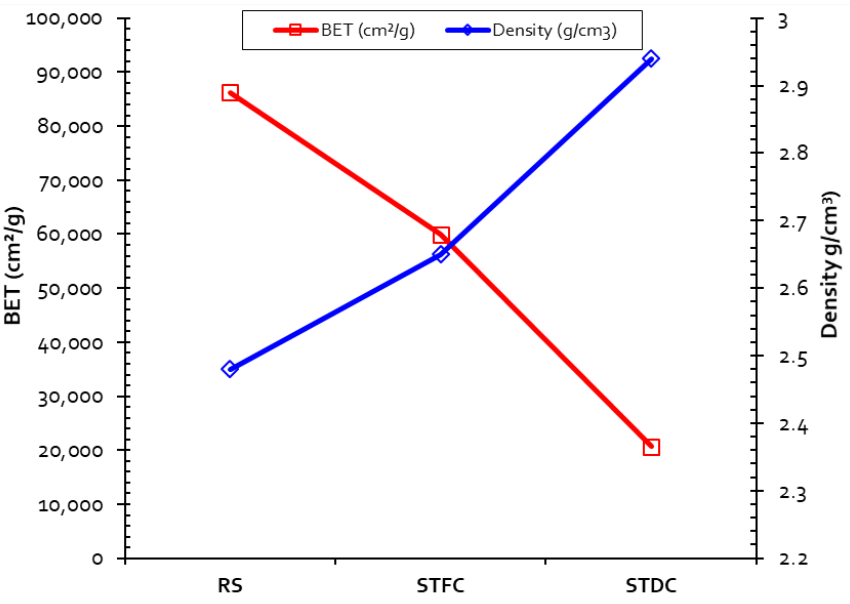
Figure 4. Evolution of density and BET surface area for RS, STFC, and STDC.